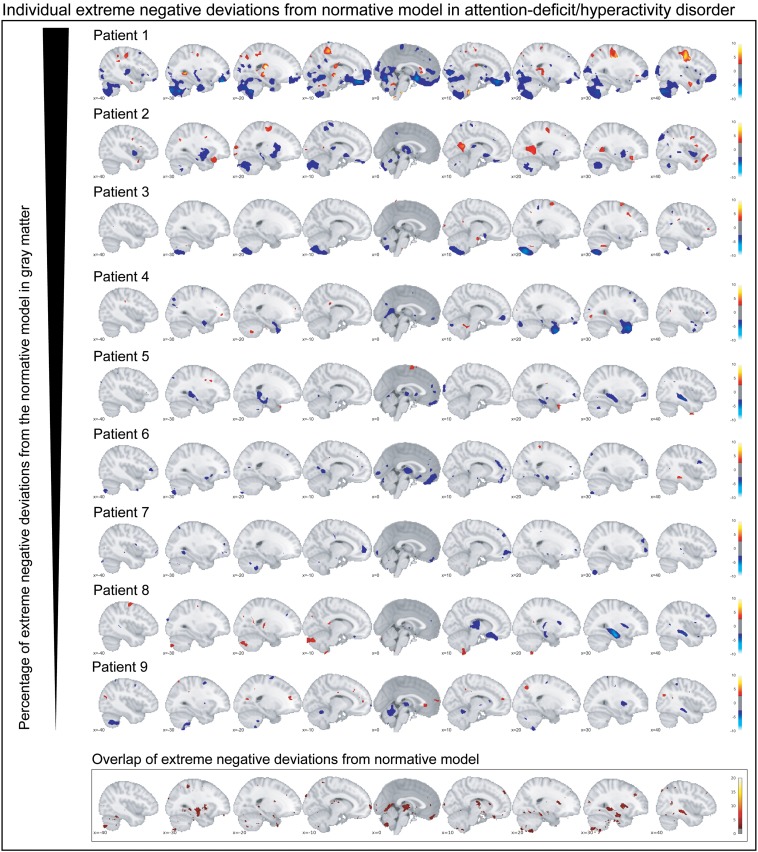
The individual extreme negative deviations from the normative model in gray matter are depicted for participants with persistent ADHD. Below the corresponding overlap map in gray matter is depicted. In summary, individual extreme deviations show a very unique pattern across participants with persistent ADHD.